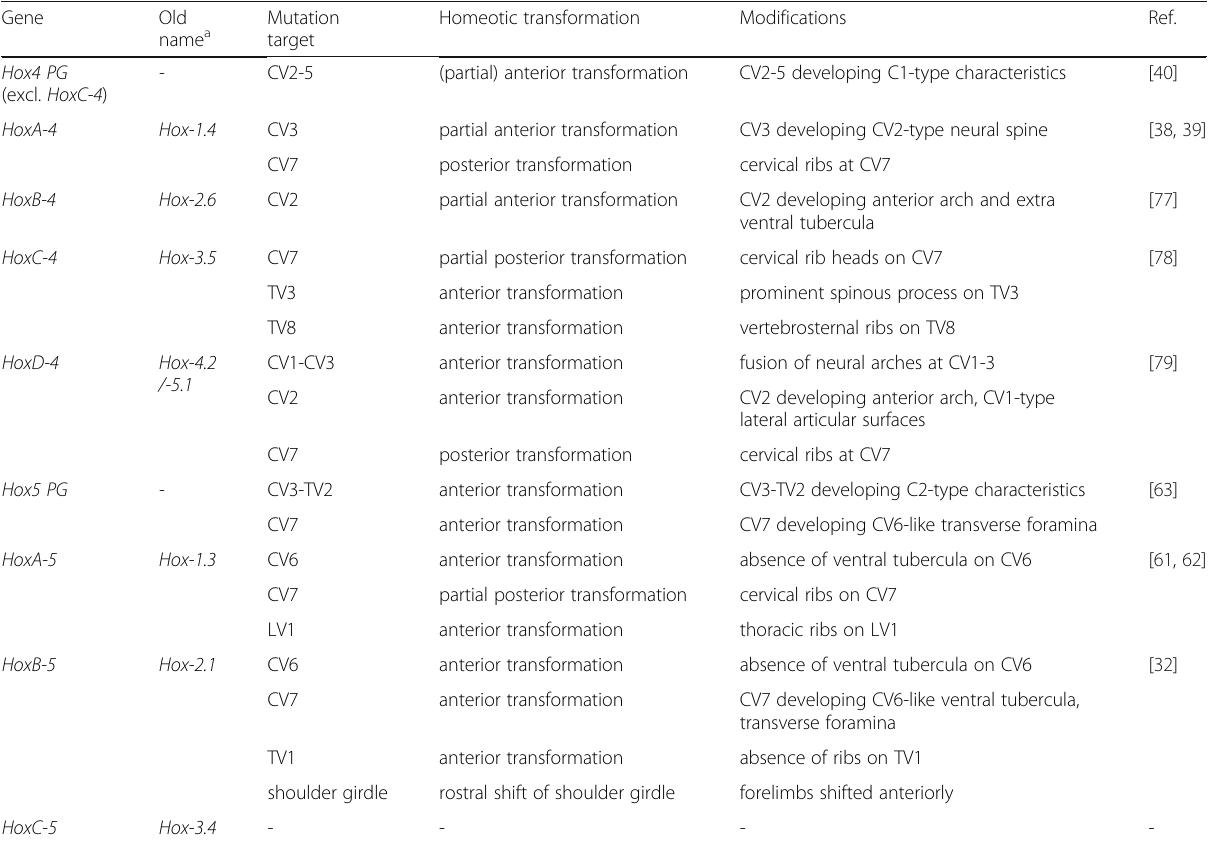
Table 4 Single and multiple loss-of-function homozygote mutations in Hox4 and Hox5 paralog group (PG) and effect on the axial skeleton in the mouse, in particular focusing on the cervical vertebral column. Mutations in Hox3 and Hox6 PG also affect vertebral development, but are usually confined to the atlanto-occipital and thoracic region [75, 76]. Ref. =